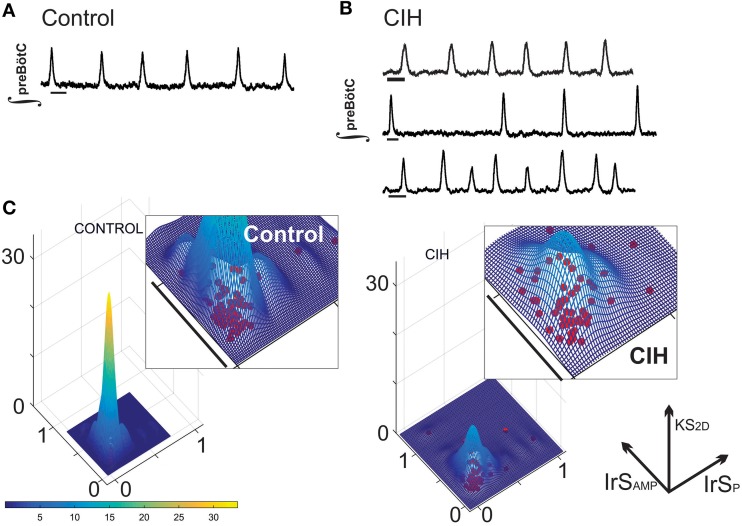
CIH disperses short-term regularity of rhythm generation. (A) Representative integrated trace of the network preBötC rhythm (∫) from a control slice where short-term (i.e., burst-to-burst) variability is regular. Scale Bar: 2 s. (B) While some preBötC rhythms from subjects exposed to CIH were indistinguishable (top), many rhythms exhibited obvious burst-to-burst variability in period (middle), and/or amplitude (bottom). Scale Bar: 2 s. (C) Plotting the kernel density estimation functions of the IrSAmp and IrSP for CIH and control groups reveals that CIH disperses the distribution of composite short-term variability compared to control rhythm.